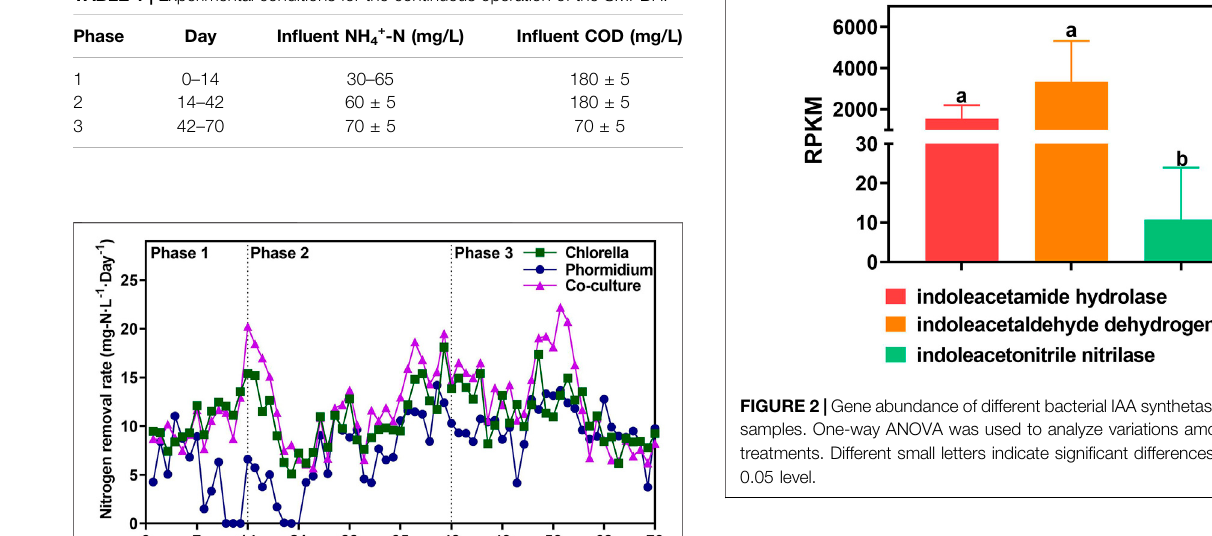
TABLE 1 | Experimental conditions for the continuous operation of the SMPBR.